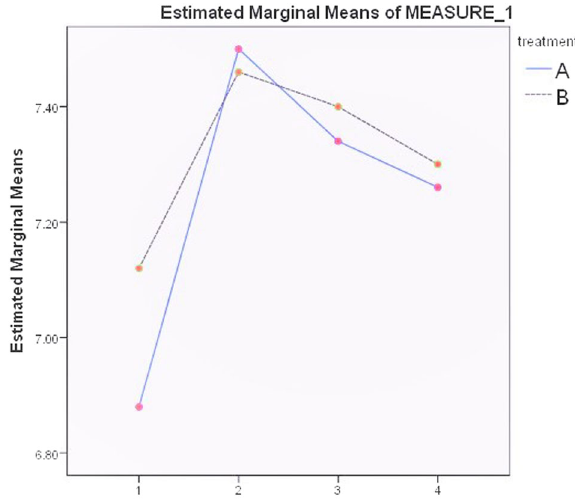
Fig. 2 The change of saliva pH values of groups A and B in the studied time points. (X-axis: T0,T1,T2 and T3; Y-axis: pH values).